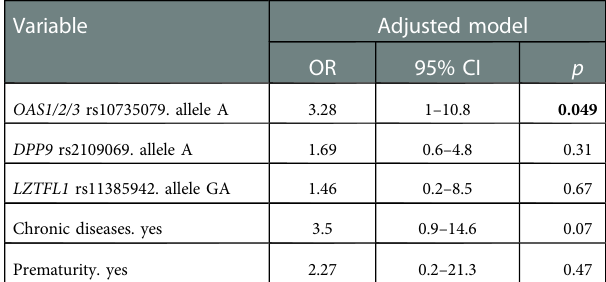
TABLE 4D Multivariate logistic model of genetic and clinical factors associated with pneumonia development in children